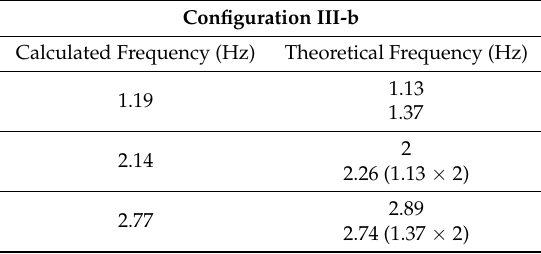
Table 3. Comparison of the calculated and theoretical natural